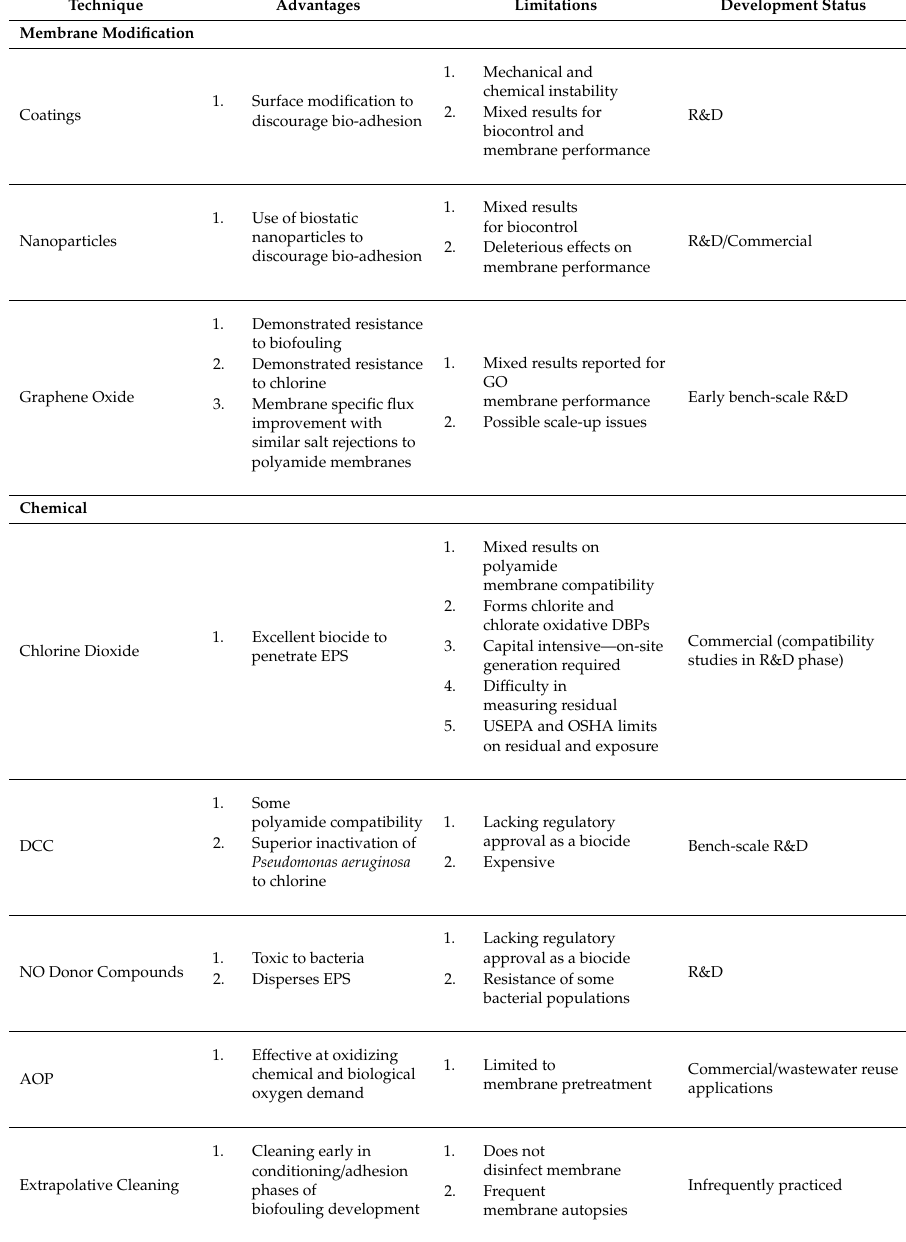
Table 21. Summary of the salient advantages and limitations as well as development status for the most promising new techniques for polyamide membrane biofouling